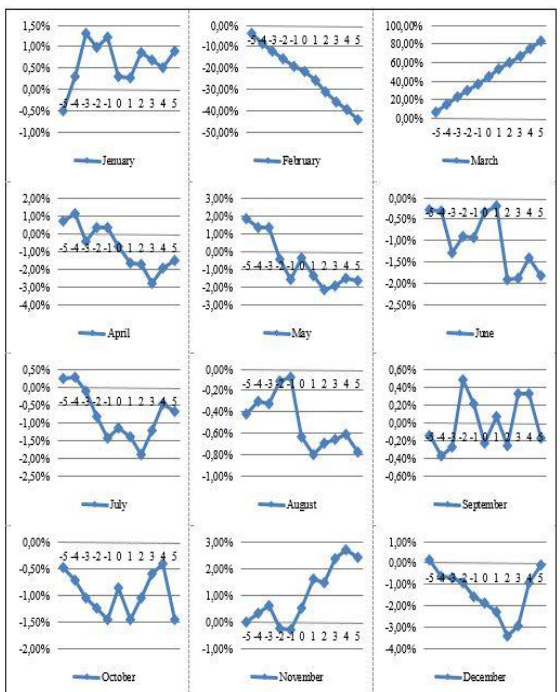
Figure 2. Cumulative Abnormal Returns (CAR) Graphs (2012)